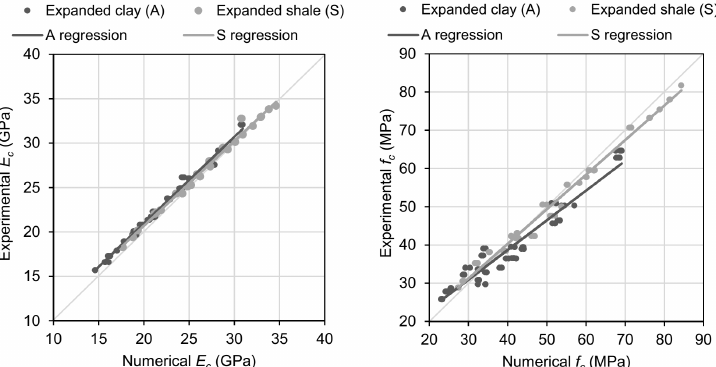
Figure 6 C omparison of the linear regression models for expanded clay (A) and expanded shale (S) aggregates and each mechanical property: left - Young’s modulus; right - compressive strength.